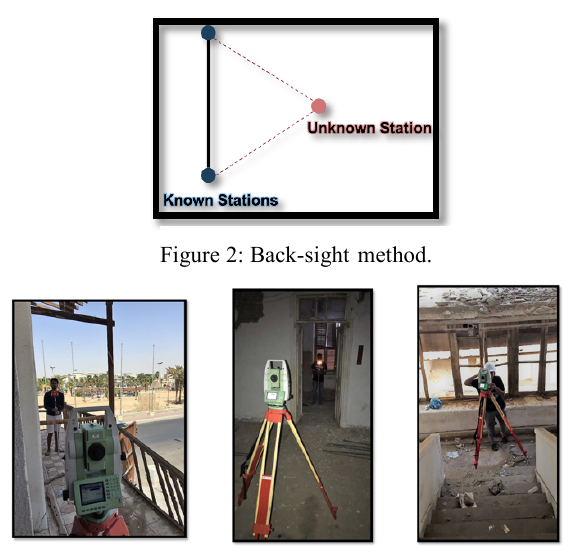
Figure 3: Using the Total-station on the site.